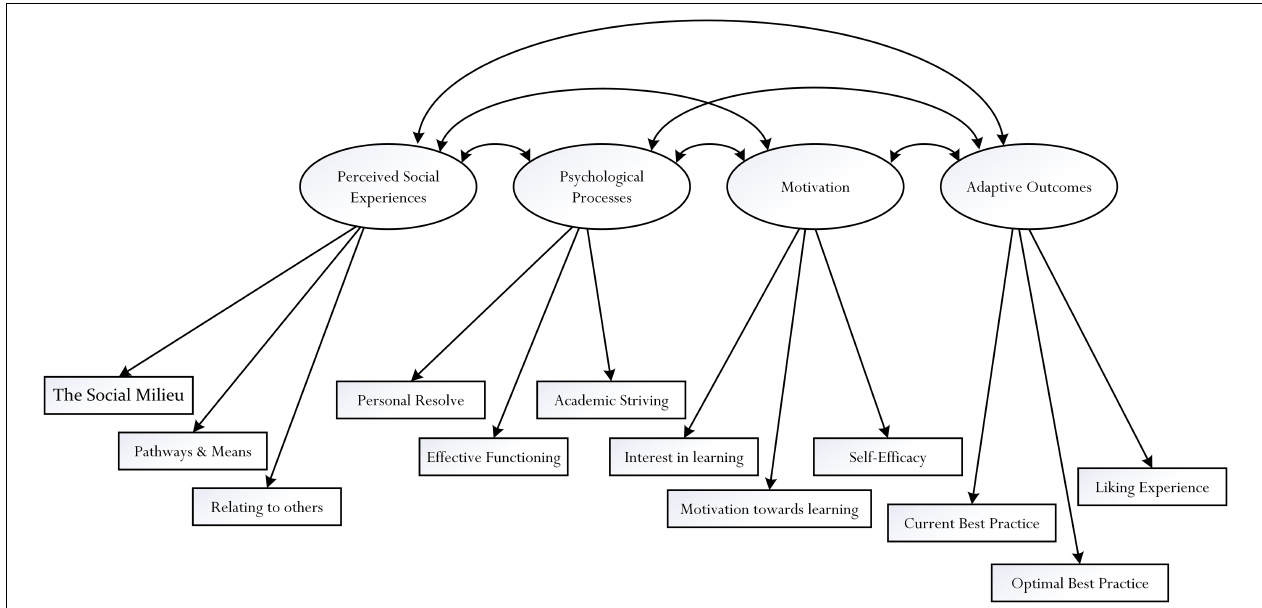
FIGURE 2 | Factorial structure of perceived social experiences, psychological experiences, motivation, and adaptive outcomes. Each measured indicator (e.g., the Social Milieu) is made of a composite score of responses from the five